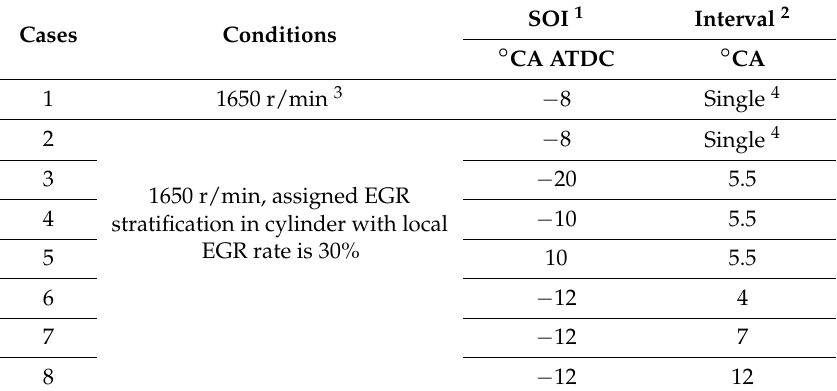
Table 1. Simulation conditions of exhaust gas recirculation (EGR) stratification combustion. Cases Conditions